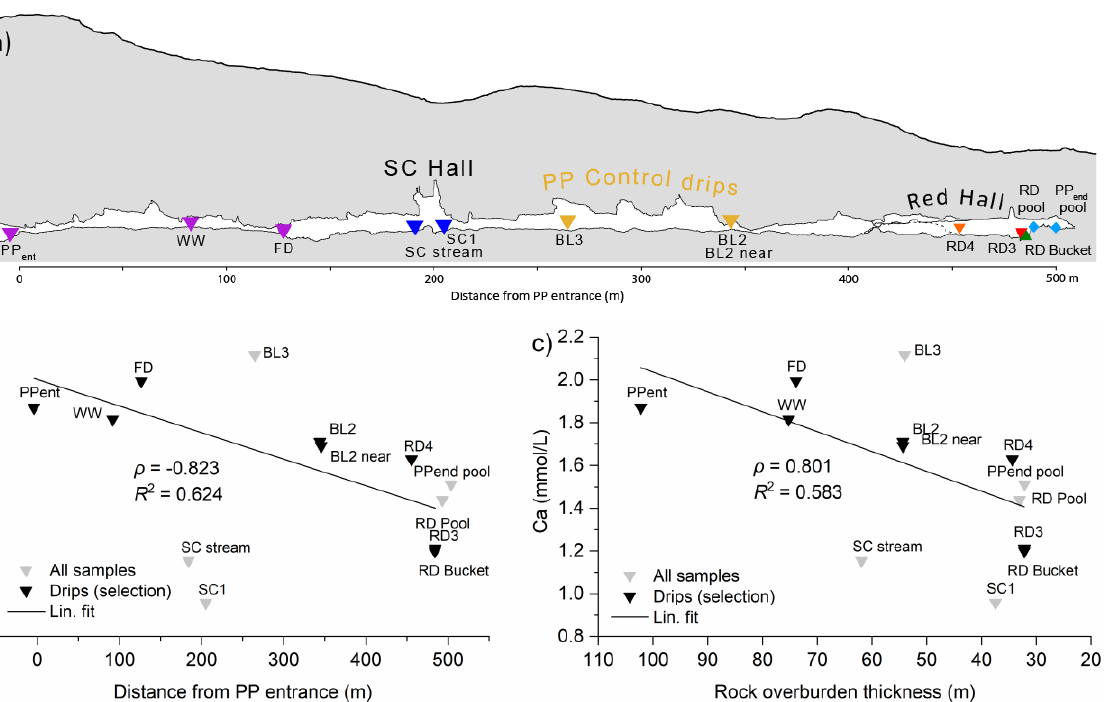
Figure 12. ( a ) Schematic profile of Pisani Passage (PP) showing the sites sampled during a single occasion on 14 July 2021. The profile of the surface was acquired from LiDAR scans and followed the extent of the passage [37]. The colours of sampling sites are analogous to the one used in Figure 2b,c. ( b ) Relationship between the calcium concentrations in the dripwaters and the distance from the entrance of Pisani Passage or ( c ) the thickness of the rock overburden determined by the LiDAR digital elevation model. Note the inverted X -axis in ( c ). Linear regressions were only calculated for the drip samples (black triangles) but excluding samples BL3, SC1 and the SC stream, as these were considered